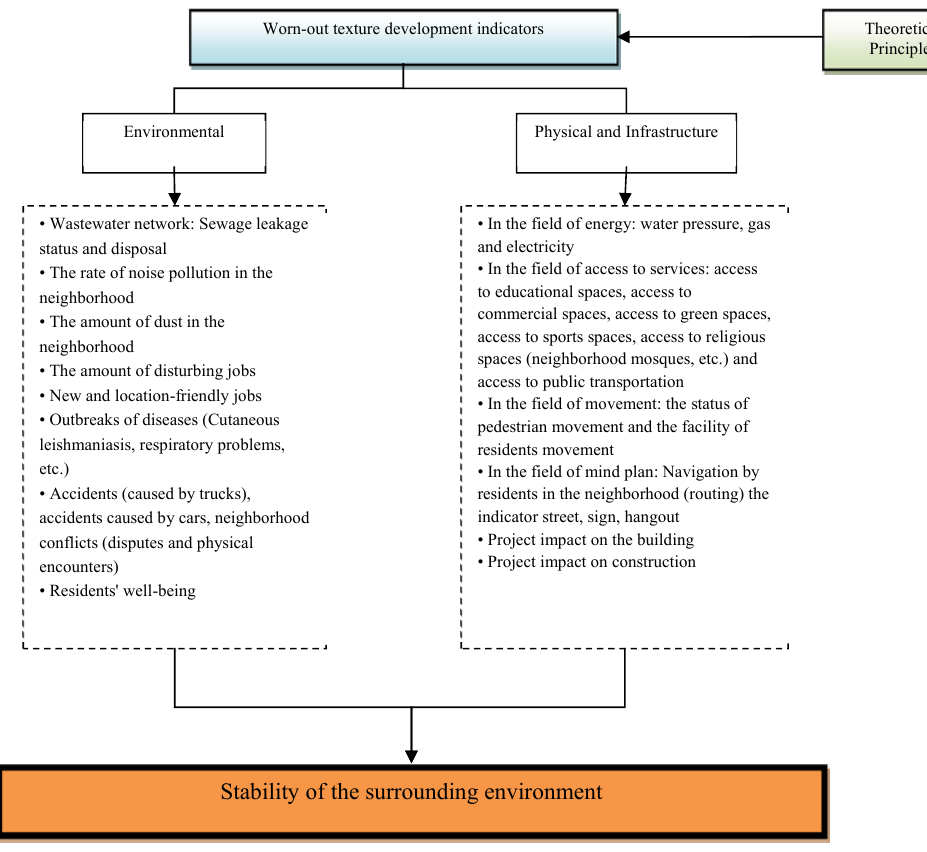
Fig. 1: Theoretical framework of study